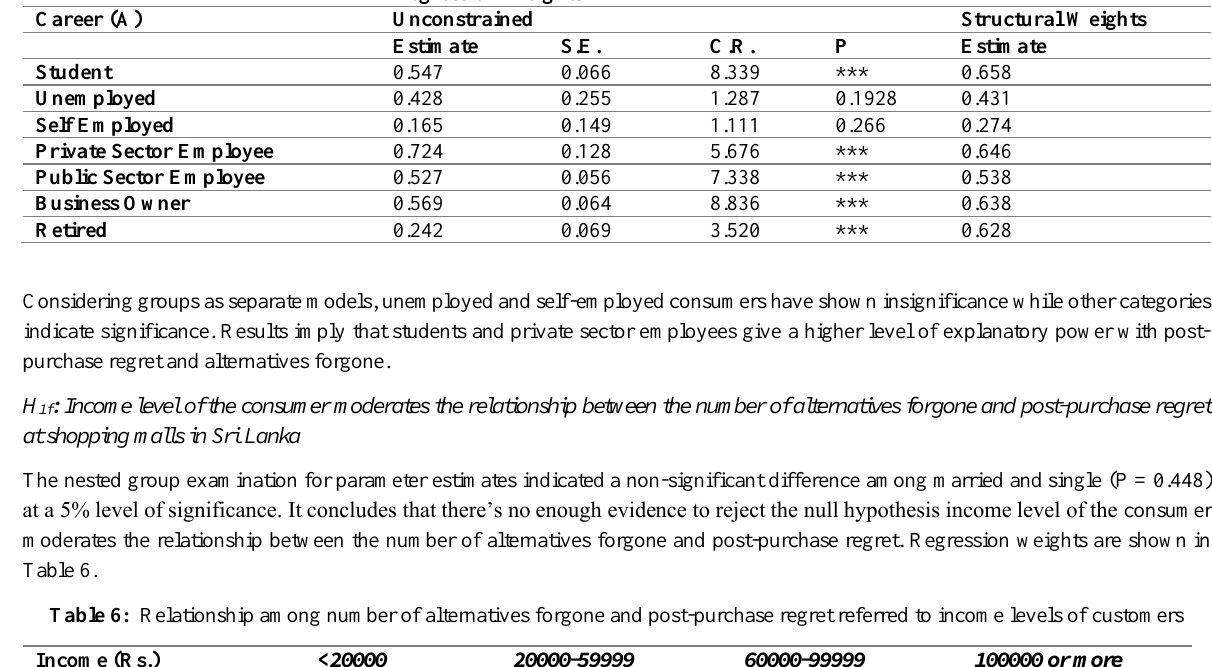
Table 5: Relationship among number of alternatives forgone and post-purchase regret concerning career of the customer Regression Weights